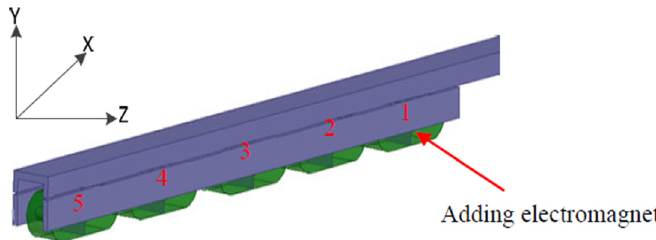
Figure 8. 3D FEM model of five-coil structure.